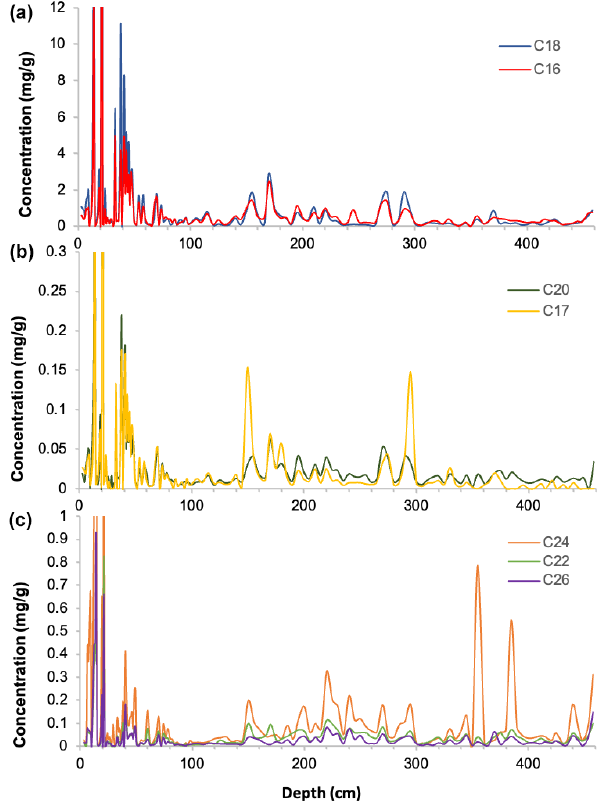
Figure 2. Fatty acid concentrations (µgg − 1 of dry sediment) with depth from core DTGC2011 (a) C 16 and C 18 fatty acids; (b) C 17 and C 20 fatty acids; and (c) C 22 , C 24 and C 26 fatty acids.